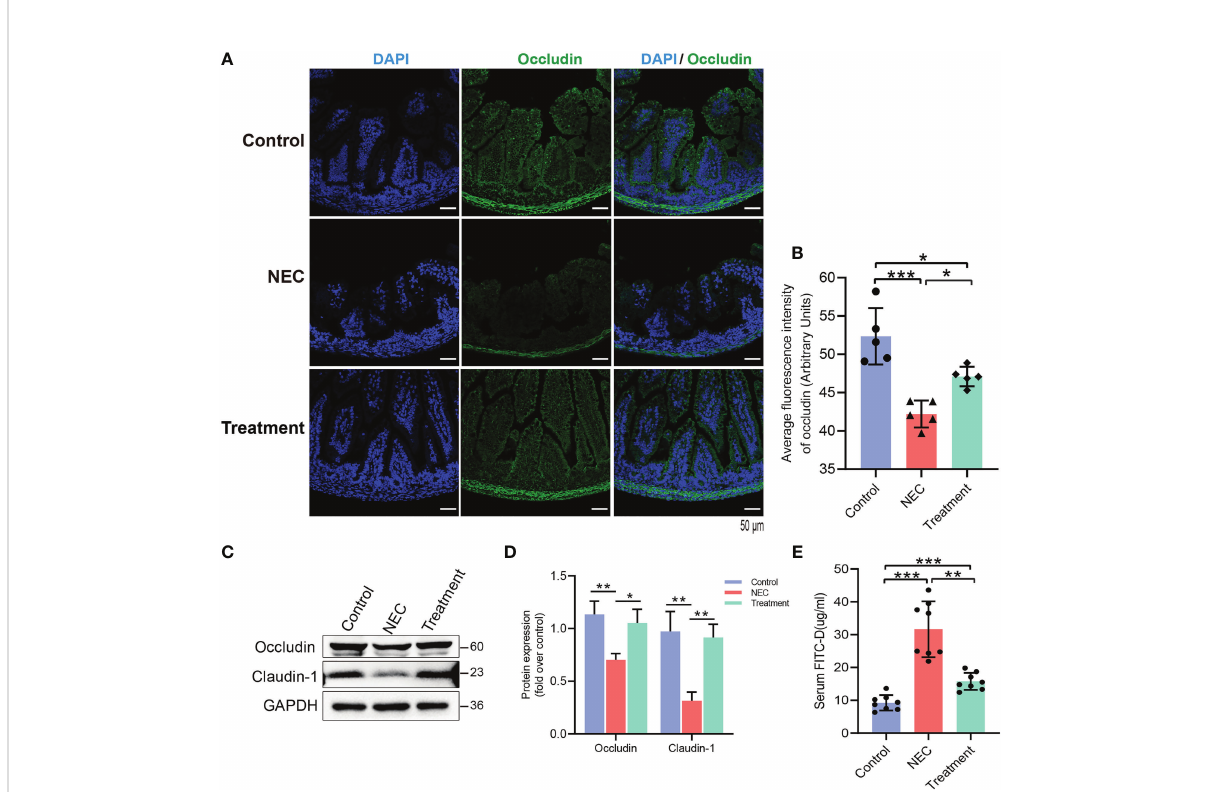
FIGURE 5 Evaluation of the effect of MD2 on intestinal mucosal barrier function in NEC rats. (A, B) Occludin expression in the intestinal tissue of rats. Occludin (green) and DAPI staining of nuclei (blue). The scatter plots represent the mean value of the average optical density in 3 random fi elds in each section of the quanti fi cation diagram. Scale bar, 50 m m, n=5. (C, D) The protein expression of occludin and claudin-1 in the intestines of the three groups was analyzed by Western blotting (n=3). (E) The intestinal permeability was detected by FITC-D (n=8). The p value